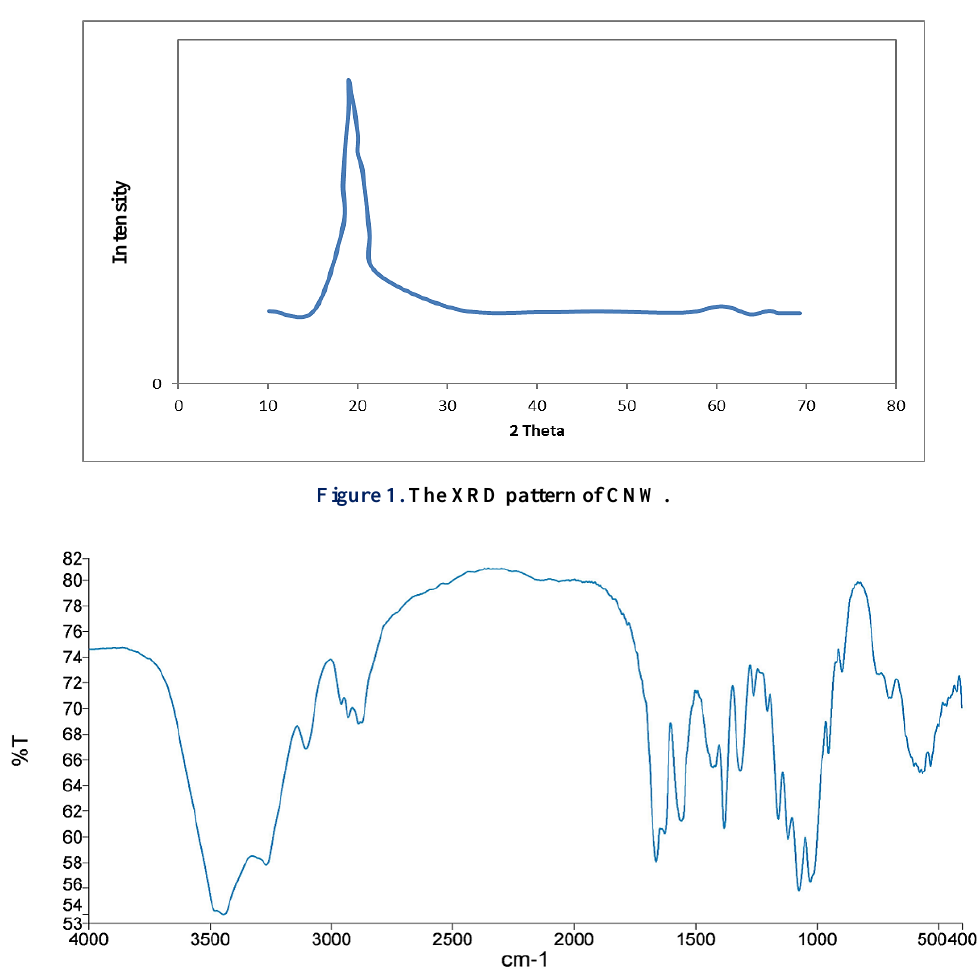
Figure 2. The FTIR pattern of synthesized CNW.